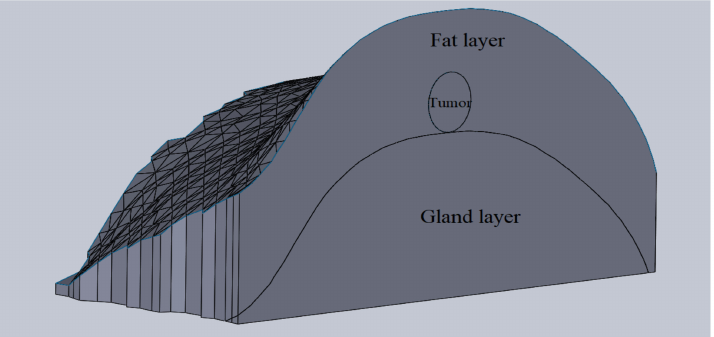
Figure 5. A 3D personalized multilayer model of a breast consisting of gland and fat layers, and a